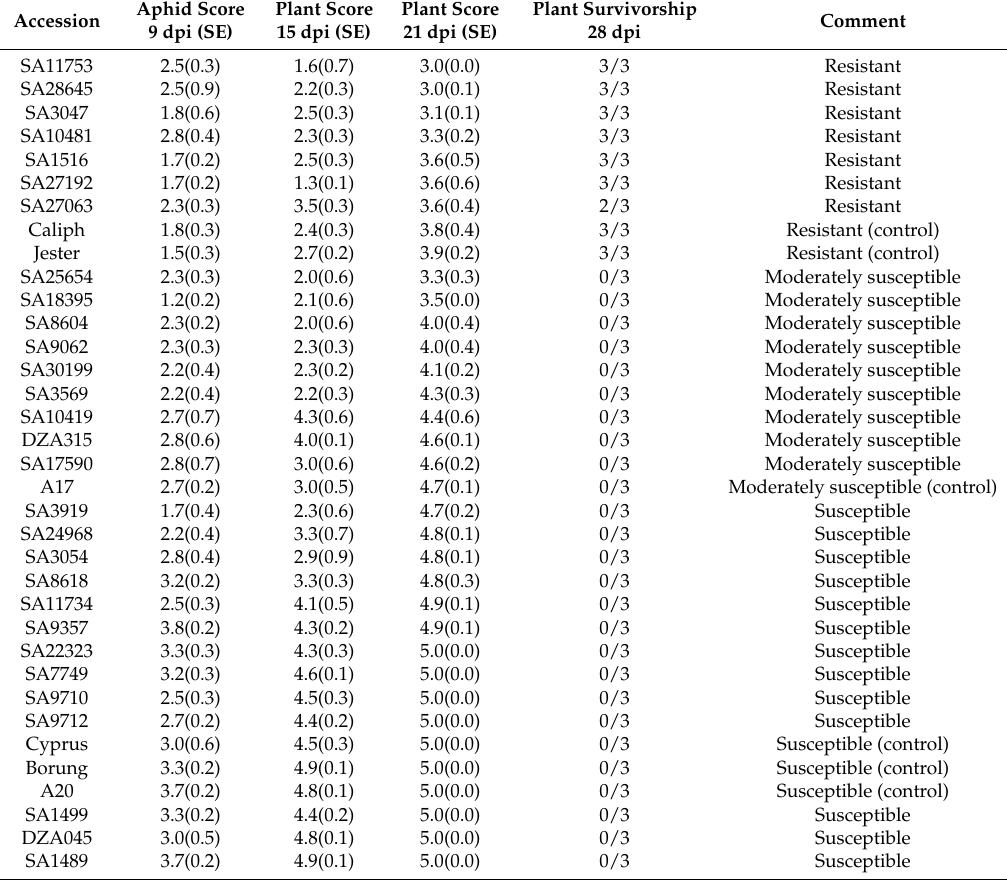
Table 1. Evaluation of 35 Medicago truncatula accessions from the South Australian Research and Development Institute (SARDI) core collection for resistance to an Australian biotype of pea aphid. Each value represents the mean and standard error (SE) of three biological replicates. For the aphid population build-up, the rating scale was as described by Gao et al.